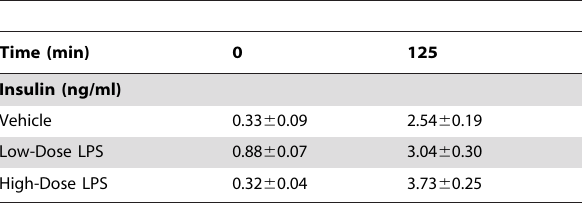
Table 1. Arterial plasma insulin levels after a hyperinsulinemic-euglycemic clamp following vehicle or LPS